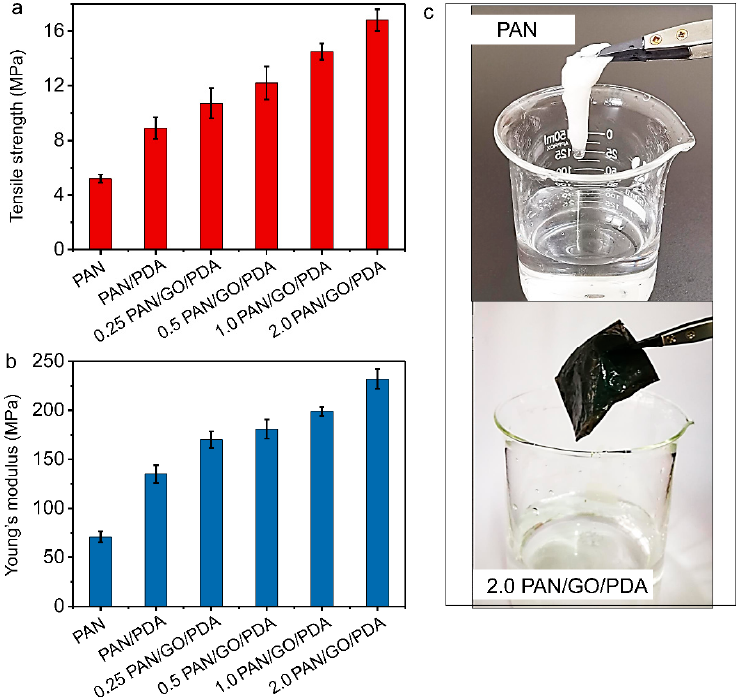
Figure 7. ( a ) Tensile strengths and ( b ) Young’s moduli of the composite membranes. ( c ) Comparison of the PAN and 2.0 PAN/GO/PDA membranes after being dipped and stirred (10 min) in